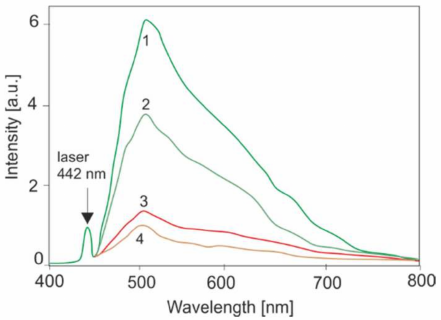
Figure 7. Decrease in autofluorescence in the mesothelium (1,2—normal tissue, 3,4—tumor).